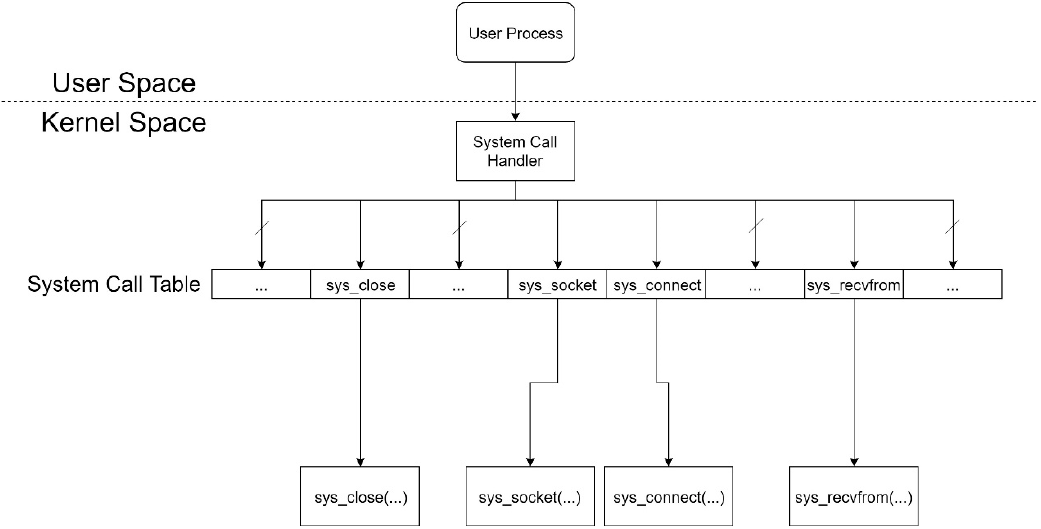
Figure 1. Original structure of a Linux system call.